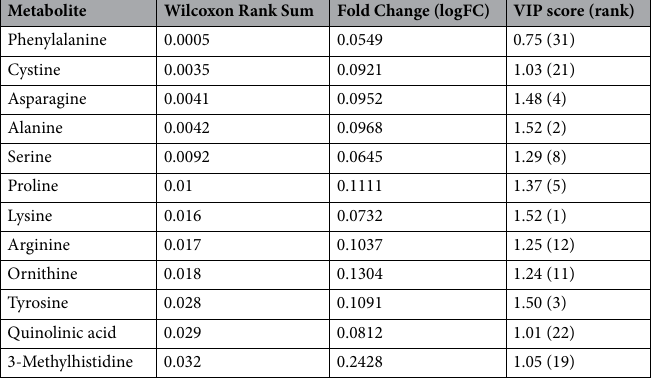
Table 1. Ranked univariate testing on all metabolites between burn Injury and non-burn (healthy)